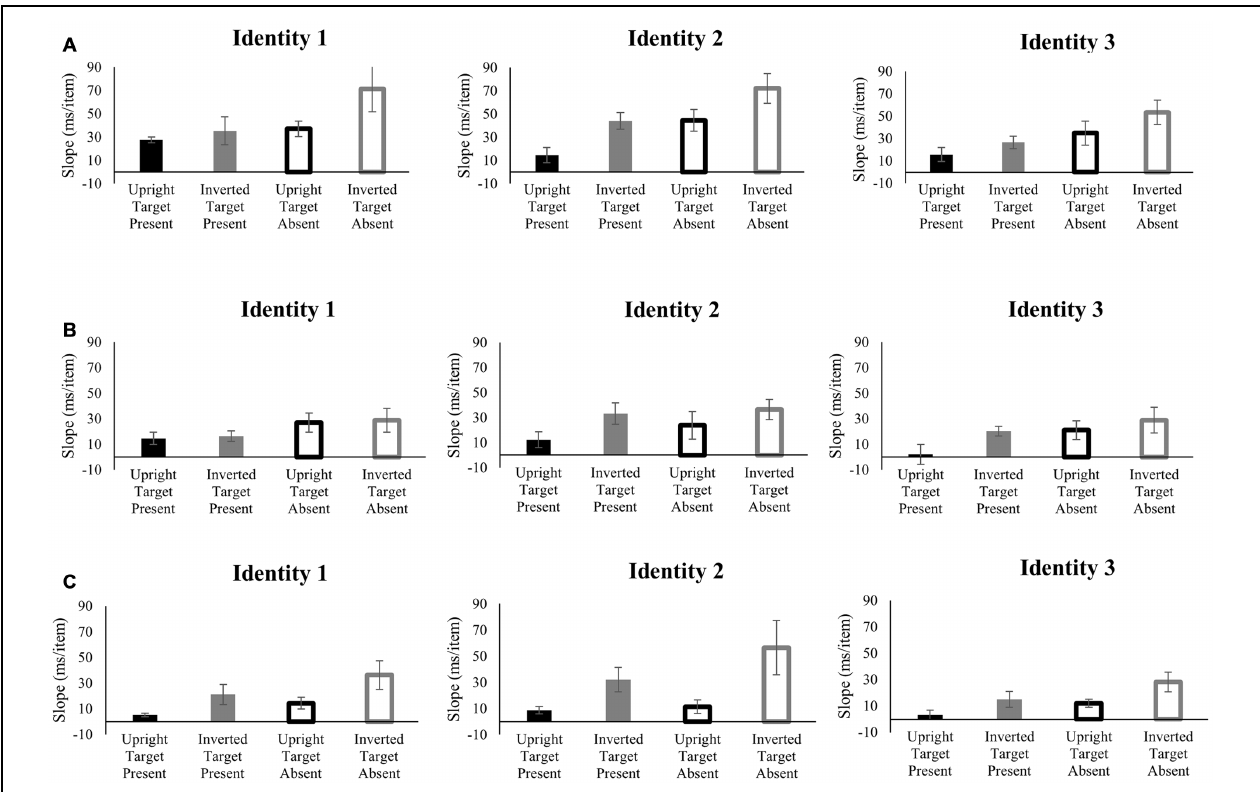
FIGURE 5 | Slopes of the reaction times as a function of search array set size for each target identity and each participant group in Experiment 3. The efficiency of search for the Mooney face targets increased with more experience (A = Group 1, B = Group 2, C = Group 3). Black bar, upright; gray bar, inverted; filled bar, target-present; hollow bar, target-absent. Error bars represent ± 1